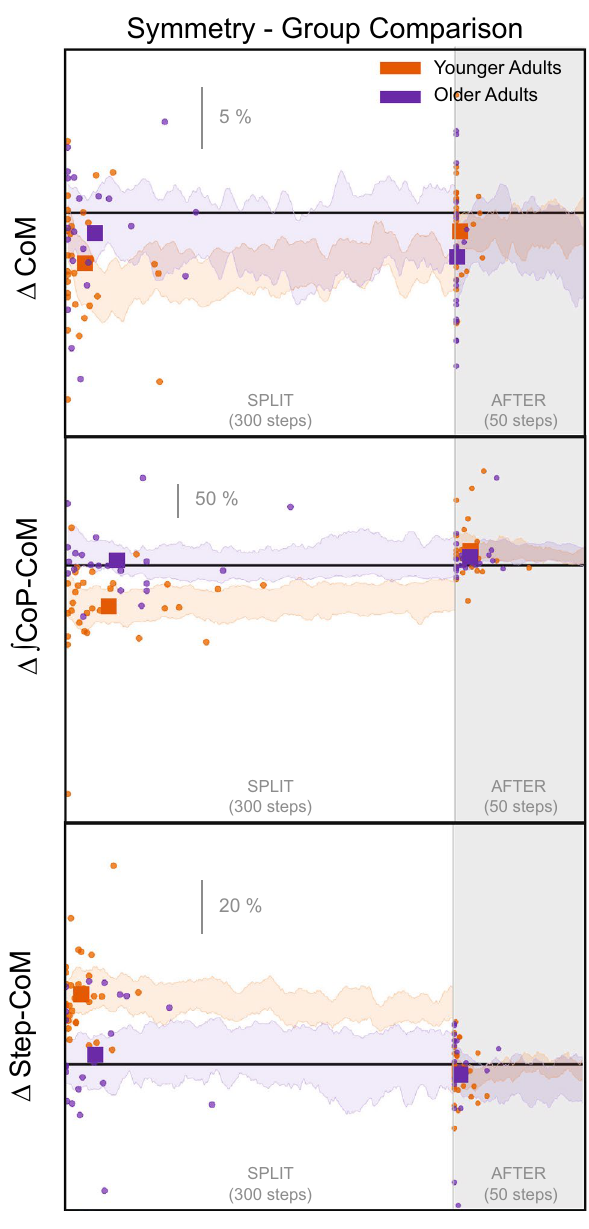
Figure 8. CoM referenced Gait parameters steps to plateau graphs for younger (orange) and older (purple) adults for split and after conditions. The small circles indicate single subject steps to plateau and the larger squares indicate the group average. The shaded area represents the 95% confidence interval for the group average symmetry. The thick black horizontal line indicates perfect symmetry.